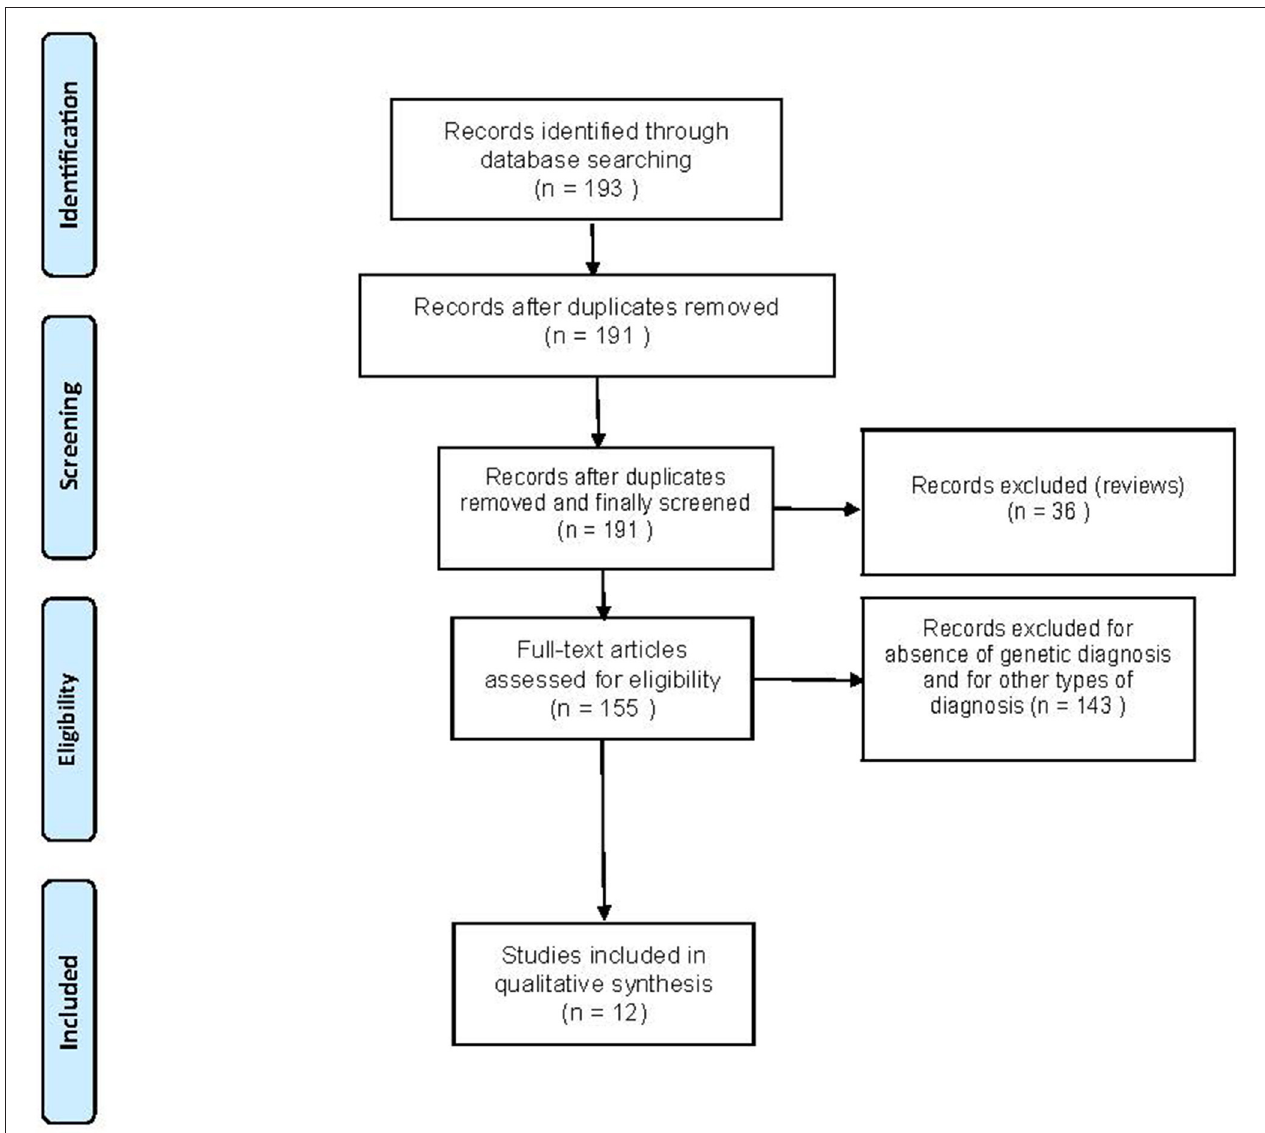
FIGURE 1 | Flowchart of the search for eligible studies on the functional MRI (fMRI) findings in Friedreich’s Ataxia